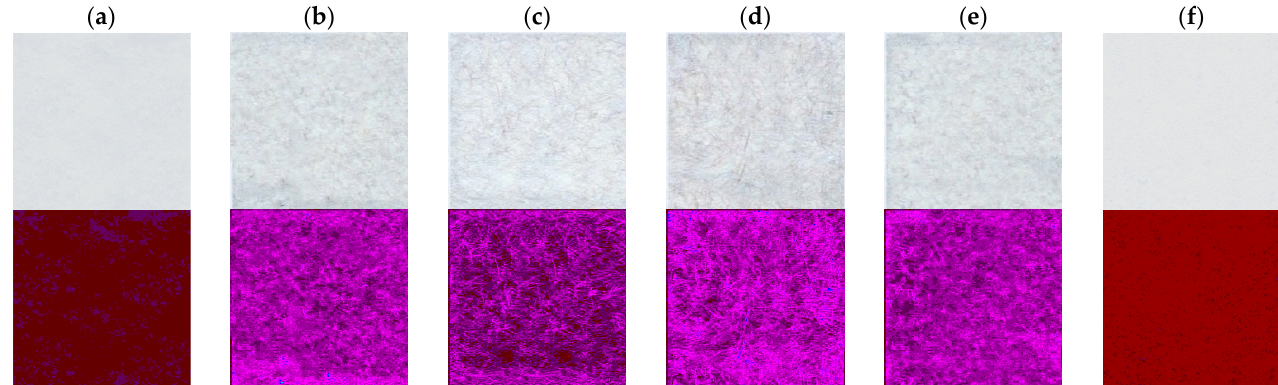
Figure 8. Analysis of the green channel after applying the RGBreader script for paper samples: ( a ) 0% PAN–PDA fibres; ( b ) 5% PAN–PDA fibres; ( c ) 10% PAN–PDA fibres; ( d ) 20% PAN–PDA fibres; ( e ) paper refined with 20% PAN–PDA fibres; ( f ) commercial printer paper. Top row: image of the samples after scanning; bottom row: green RGB channel from RGBreader.